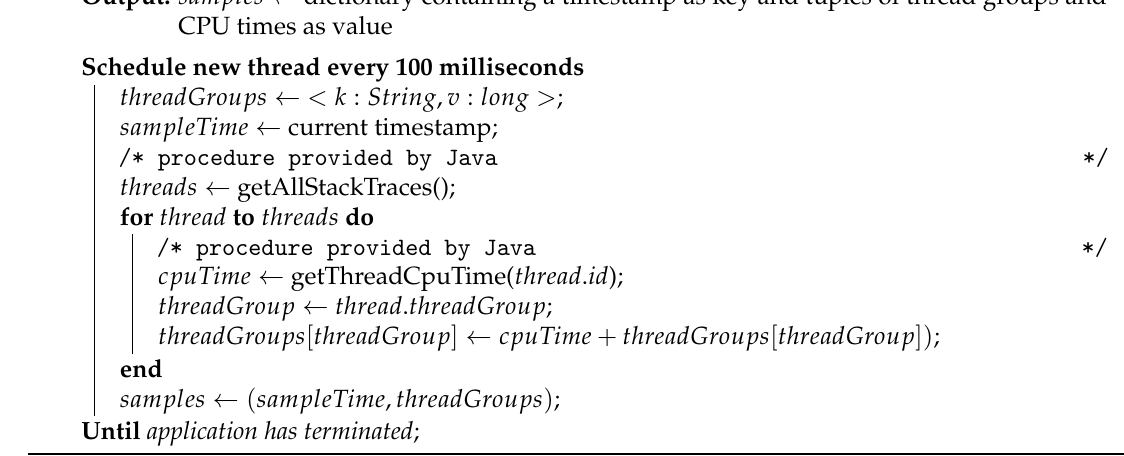
Algorithm 1: Sampling thread groups and CPU